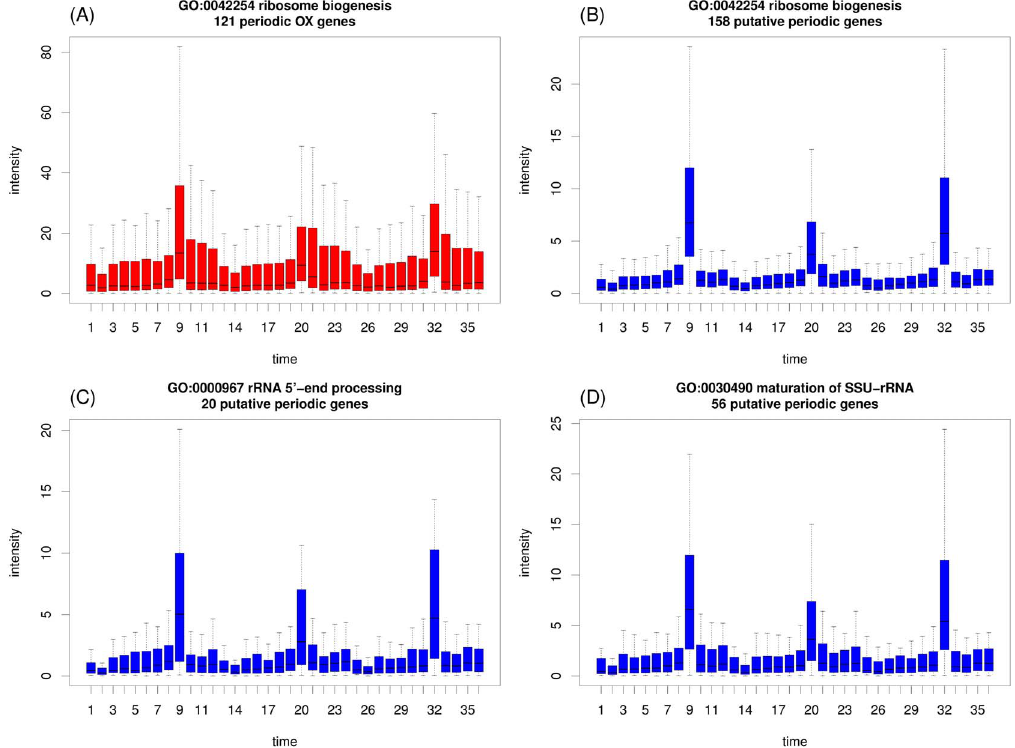
Figure 8. Boxplots of expression profiles for genes associated with enriched GO terms. Figure S1 Expression profiles of five single IMF probe- sets. Figure S2 Visualization of networks of three highly coexpressed MIPS protein complexes associated with oxidative phosphorylation. Figure S3 Distribution of the number of extracted IMFs for genes associated with ribosome biogenesis Figure S4 Boxplots of the expression profiles for (A) non-periodic, (B) PP, and (C) ND probesets. A periodicity analysis was performed using an algorithm described in [35]. (TIF)